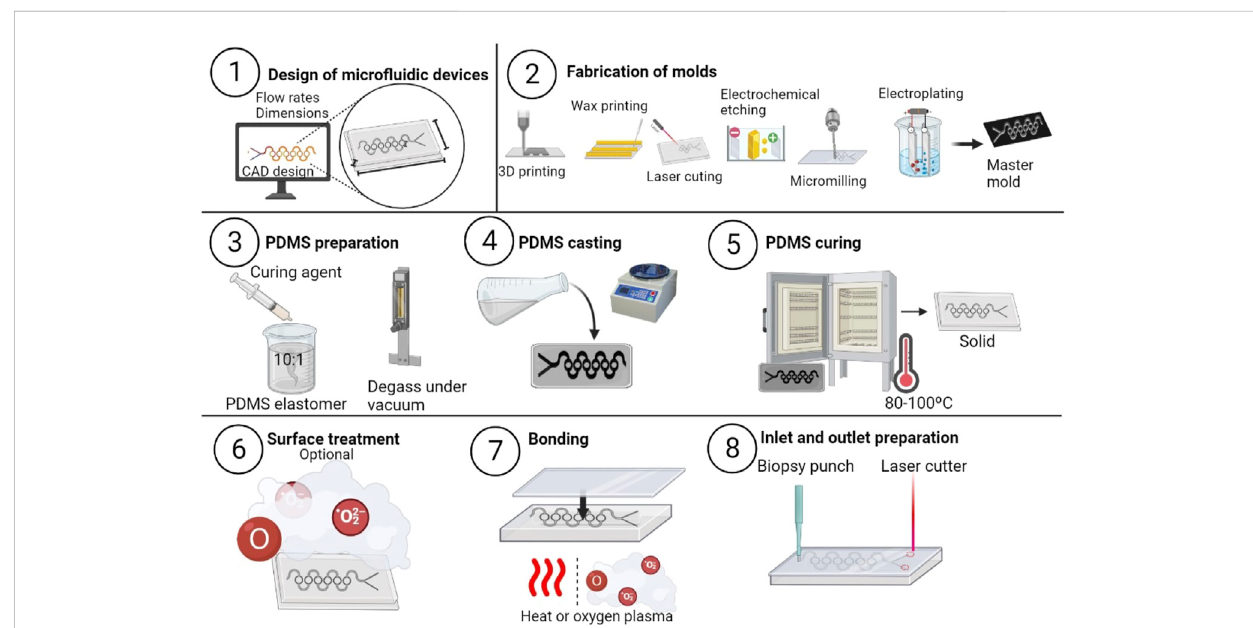
FIGURE 1 Soft lithography method to produce micro fl uidic devices. The procedure consists of the steps listed below: 1) Using CAD software, design the micro fl uidicdeviceinconsiderationofthedevice ’ sspeci fi cations.2)Createthemastermoldusingavarietyofmethods,suchas3Dprinting,waxprinting, laser cutting, micro milling, or electrochemical etching. 3) Create the PDMS solution by combining the PDM and curing agent with the PDMS. 4) Using a spincoaterorbyhand,evenlycoatthemoldwiththePDMSmixture.5)CurethePDMSlayerinanovenattemperaturesbetween80 ° Cand100 ° Cfor afewhours.ThePDMSshouldthenberemovedfromthemoldandsizedandshapedasdesired.6)TreatthesurfaceofthePDMSdevice.AttachthePDMS device to thesubstrate ’ slid using oxygen plasma orathermalbonding technique. Utilize abiopsy punch or alaser cutter to createtherequired inlets and outlets in the